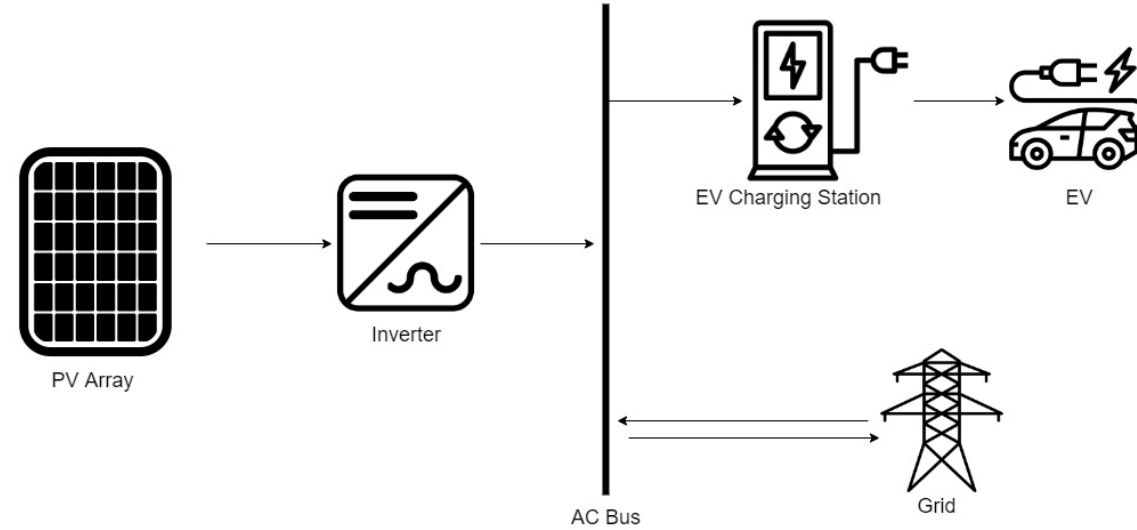
Figure 2. PV-grid charging configuration .